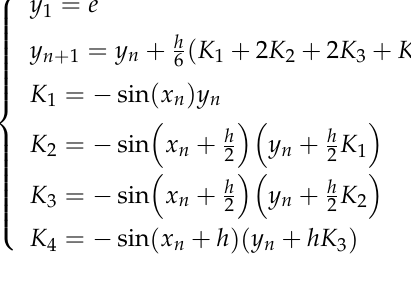
Figure 5. DQM Average error of Equations (70) and (71).